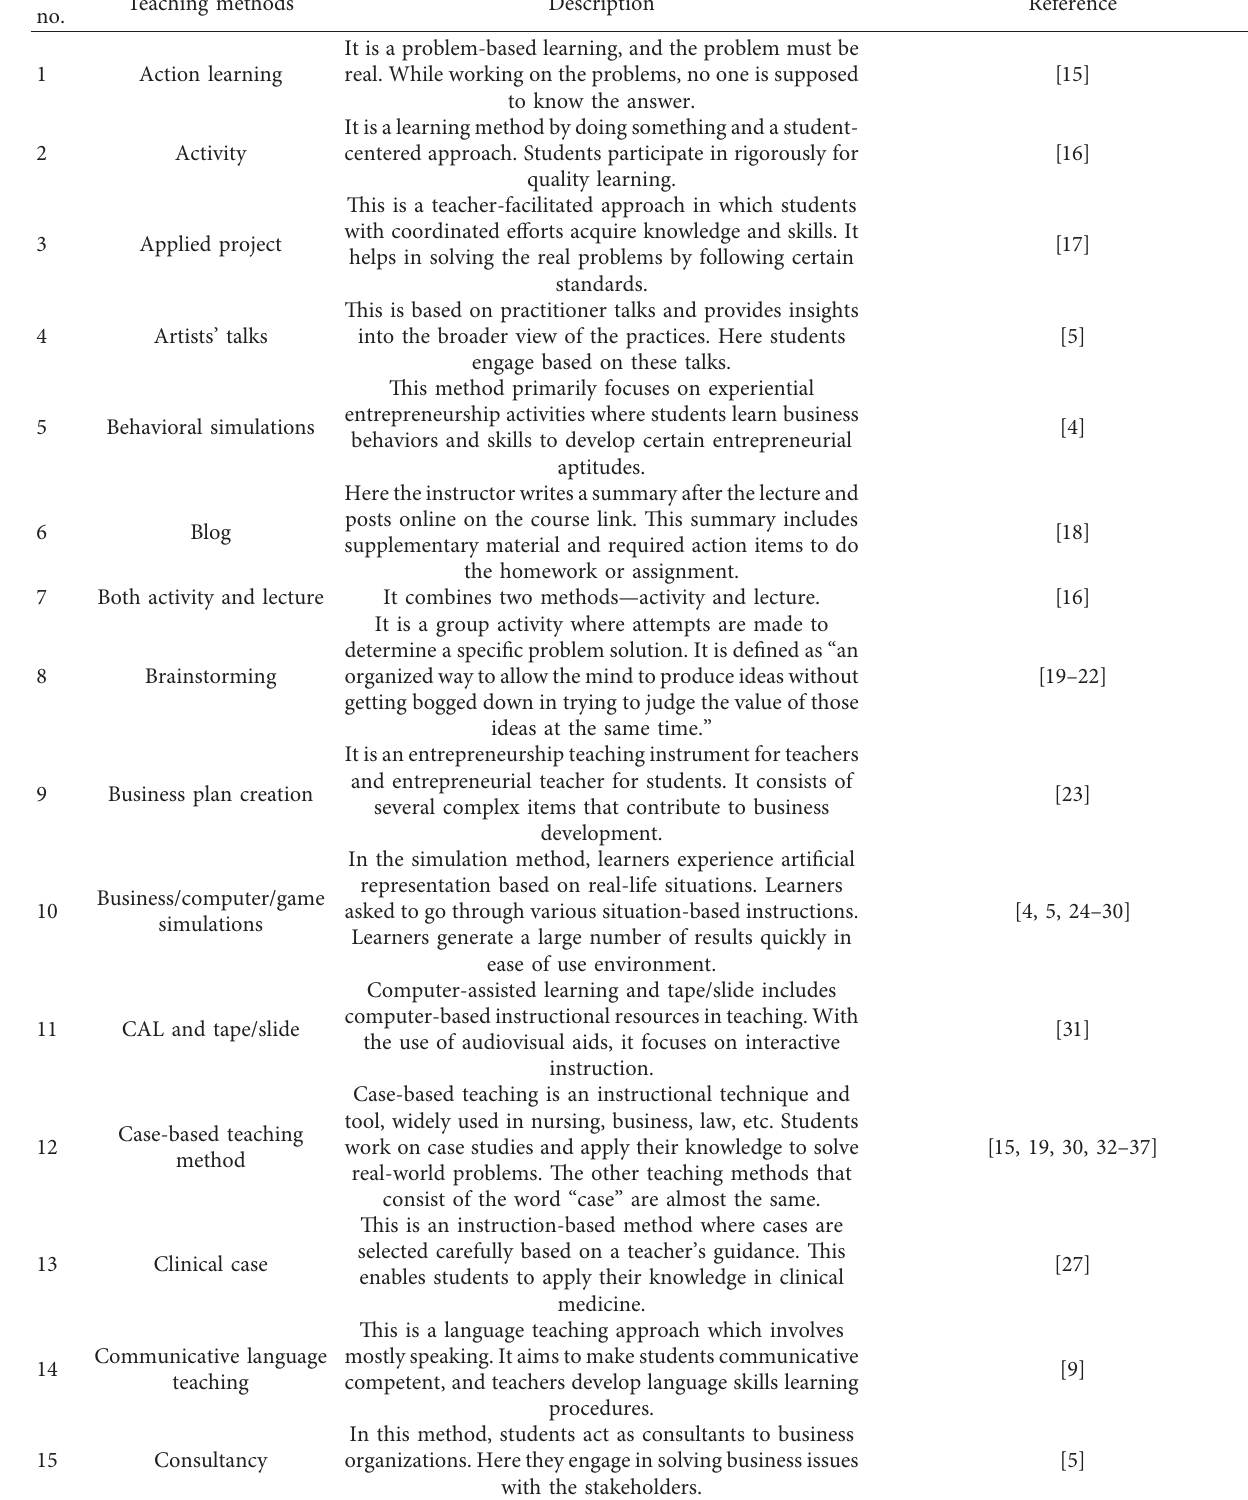
Table 1: TMs in higher